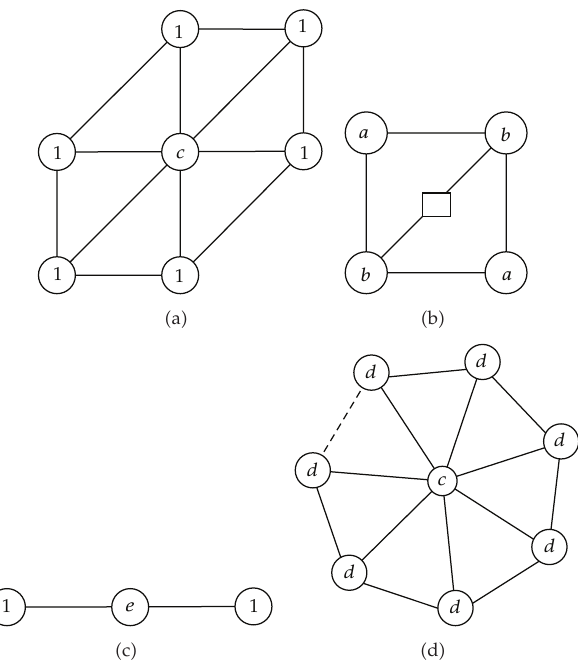
Figure 1: Masks for loop scheme with a (cid:8) 1 / 8, b (cid:8) 3 / 8, c (cid:8) 1 − nd , d (cid:8) (cid:6) 1 /n (cid:7)(cid:6) 5 / 8 − (cid:6) 3 / 8 (cid:9)(cid:6) 1 / 4 (cid:7) cos (cid:6) 2 π/n (cid:7)(cid:7) 2 (cid:7) , and e (cid:8)